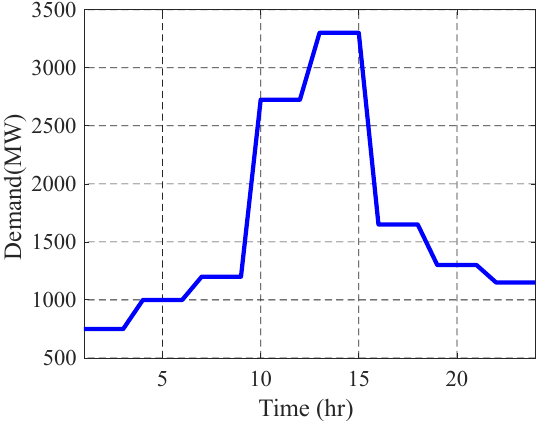
Figure 13. Load curve for case 2—test system.